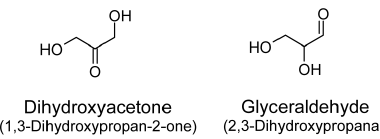
Fig. 1. Chemical structures of dihydroxyacetone and glyceralde- Figure 1: Chemical structures of dihydroxyacetone and glyceraldehyde. Dihydroxyacetone and glyceraldehyde contain both carbonyl and hydroxyl functional groups (see Figure 1), have large predicted effective Henry’s law constants (5.5 x 10 8 M atm -1 (EPA, 2013) and 2 x 10 8 M atm -1 (Saxena and Hildemann, 1996), respectively), and do not hydrate